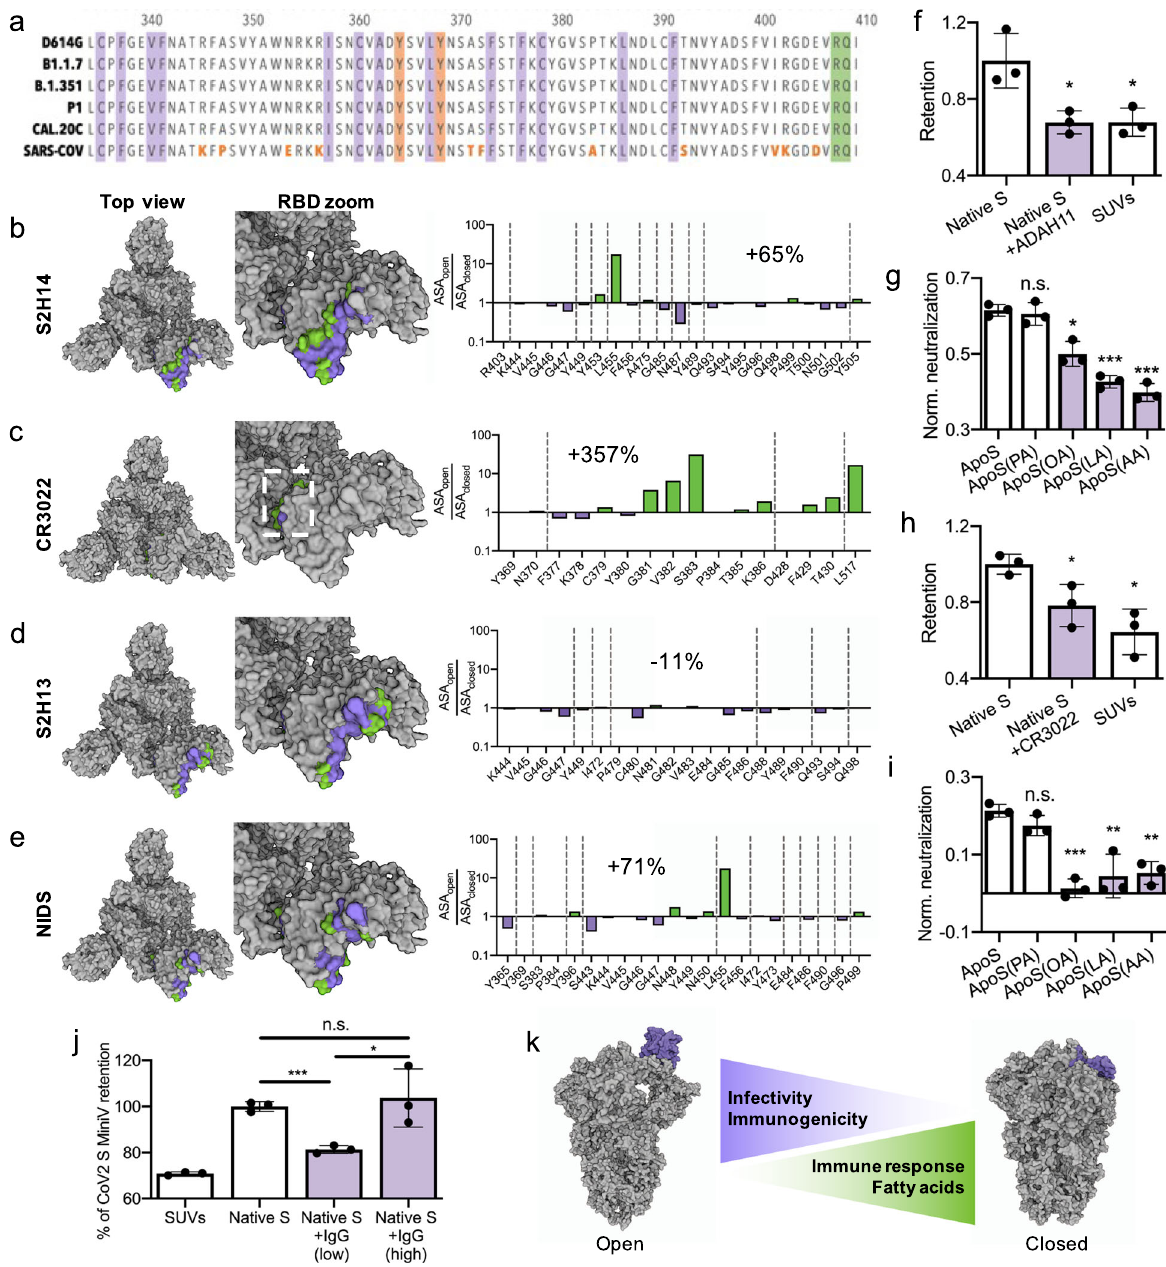
Fig. 3 FABP-regulated exposure of immunogenic S epitopes. a Sequence alignment of the FABP from fi ve SARS-CoV-2 variants of concern and SARS- CoV. Residues of the hydrophobic pocket are highlighted in purple, the hydrophilic head-stabilizing residues in green and the gating helix tyrosine in orange. Residues differing in SARS-CoV are written in orange. b – e Molecular surface representation of open S (7BNN) with ASA open-to-close ratios for the S2H14, CR3022, S2H13 epitopes and NIDS shown in green (>1) and purple (<1). Diagrams show ASA ratios for single epitope residues. Average ASA- ratio change over all epitope residues is given in %. f Retention assay for MiniVs presenting native S and incubated with MCF7 cells for 24 h. Reduction in retention by ADAH11 nanobodies was measured by addition of 1 µ M ADAH11 during the incubation period. g Native S-normalized neutralization of ADAH11 for MiniVs presenting FFA-loaded ApoS incubated with MCF7 cells for 24 h. h Retention assay for MiniVs presenting native S and incubated with MCF7 cells for 24 h. Reduction in retention by CR3022 IgG was measured by addition of 132 nM CR3022 during the incubation period. i Native S-normalized neutralization of CR3022 based for MiniVs presenting FFA-loaded ApoS incubated with MCF7 cells for 24 h. j Retention analysis with native S-normalized neutralization of MiniVs by convalescent COVID-19 patient serum-derived IgGs under low (0.1 µ M) and high (1 µ M) LA/AA concentrations. k Model of FFA as molecular switches that couple local in fl ammatory states to SARS-CoV-2 S immunogenicity. Results in f – j are shown as mean ± SD from at least n = 3 biological replicates in each experimental condition, * p < 0.05, ** p < 0.005, *** p < 0.0005, unpaired two-tailed t -test. Source data are provided as a Source Data fi le.